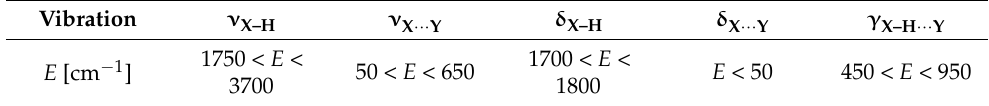
Table 1. Energy characteristics of normal vibrations of hydrogen